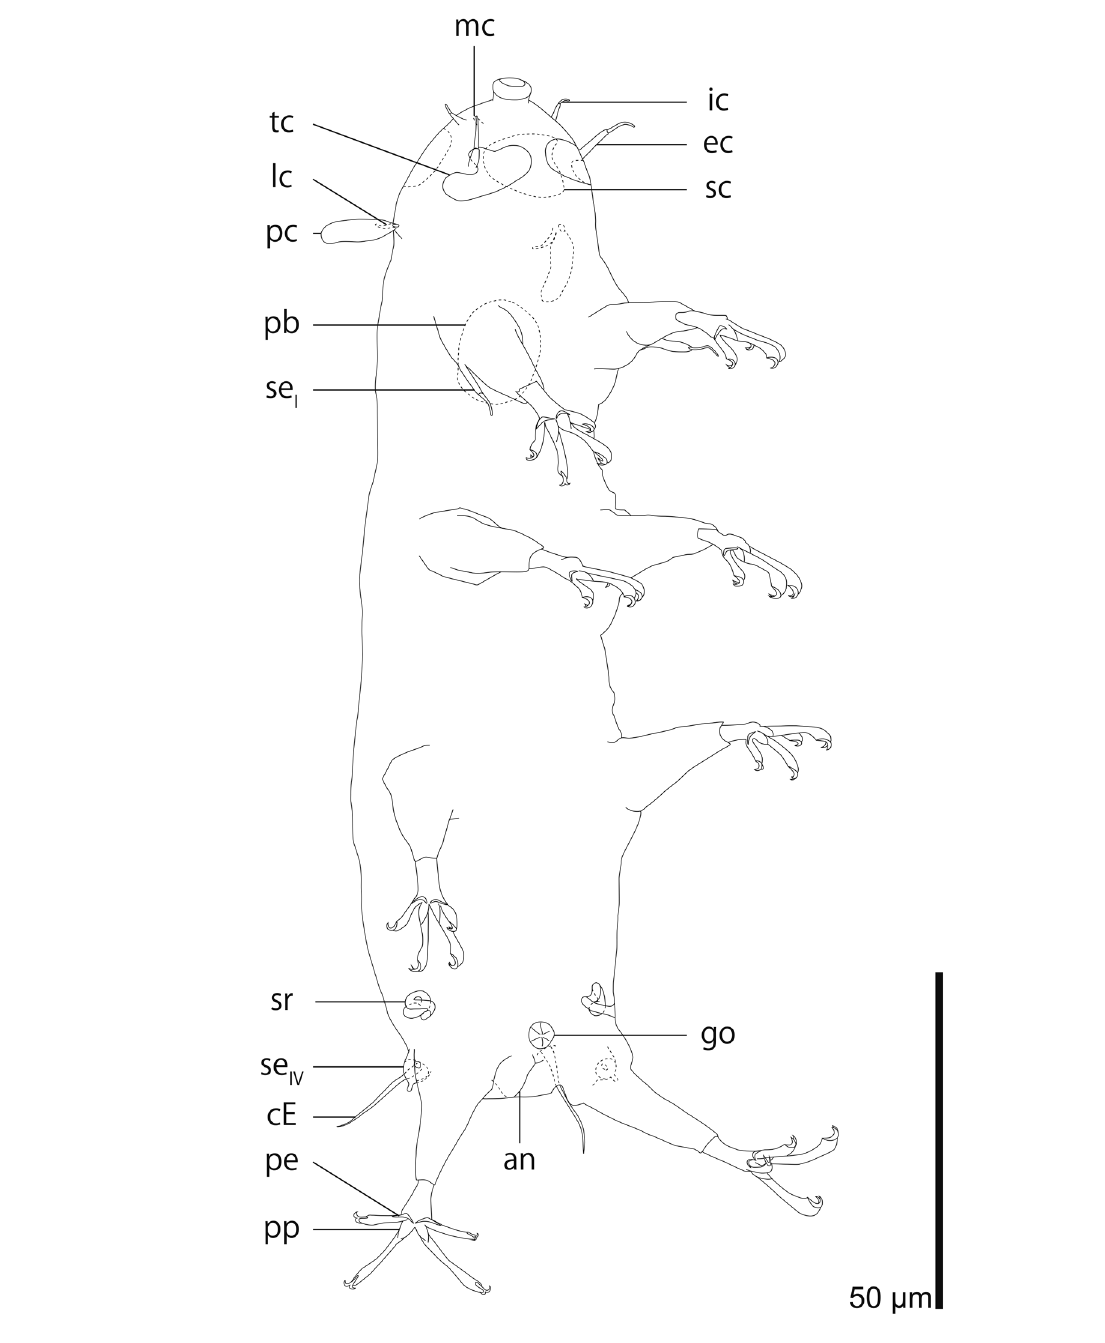
Fig. 6. Drawing of Angursa seisuimaruae sp. nov. (KUZ